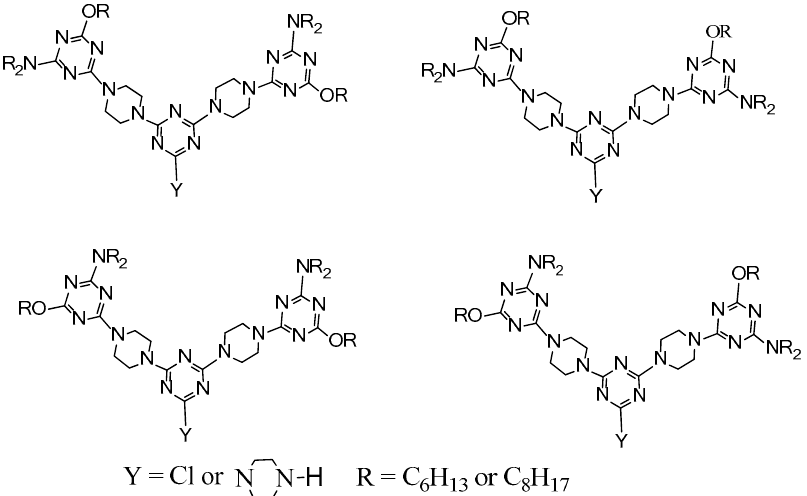
Figure 3. Structures of dendrimers ( 5 ) and ( 6 ) without a C 2 -symmetry and structures of dendrimers ( 7 ) and ( 8 ) with a C 2 -symmetry.